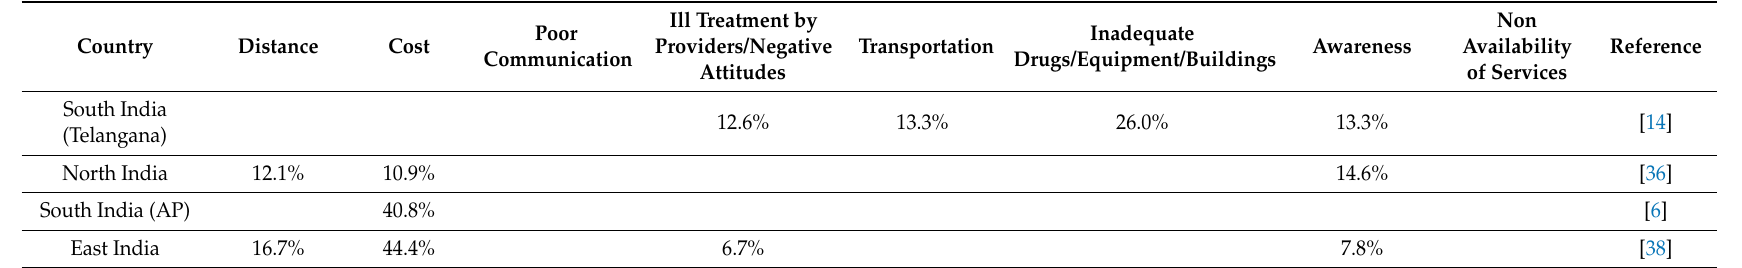
Table 3. Barriers to accessing healthcare services in South